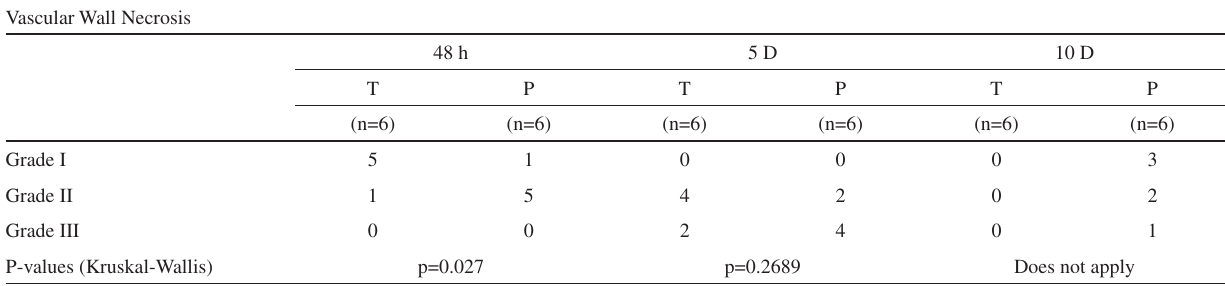
P-values (Kruskal-Wallis)